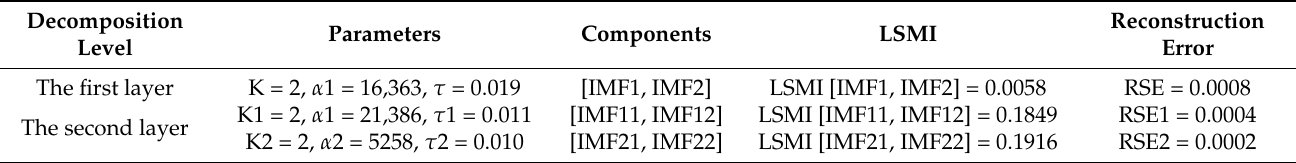
Table 3. The measurements obtained by